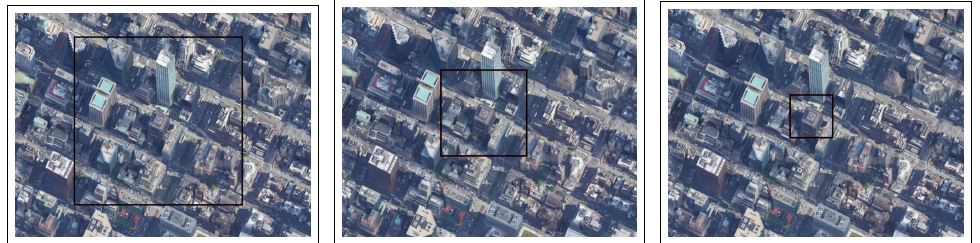
Figure 4. Location #1: 200 m (in the left image), 100 m (in the center image), 50 m (in the right image).